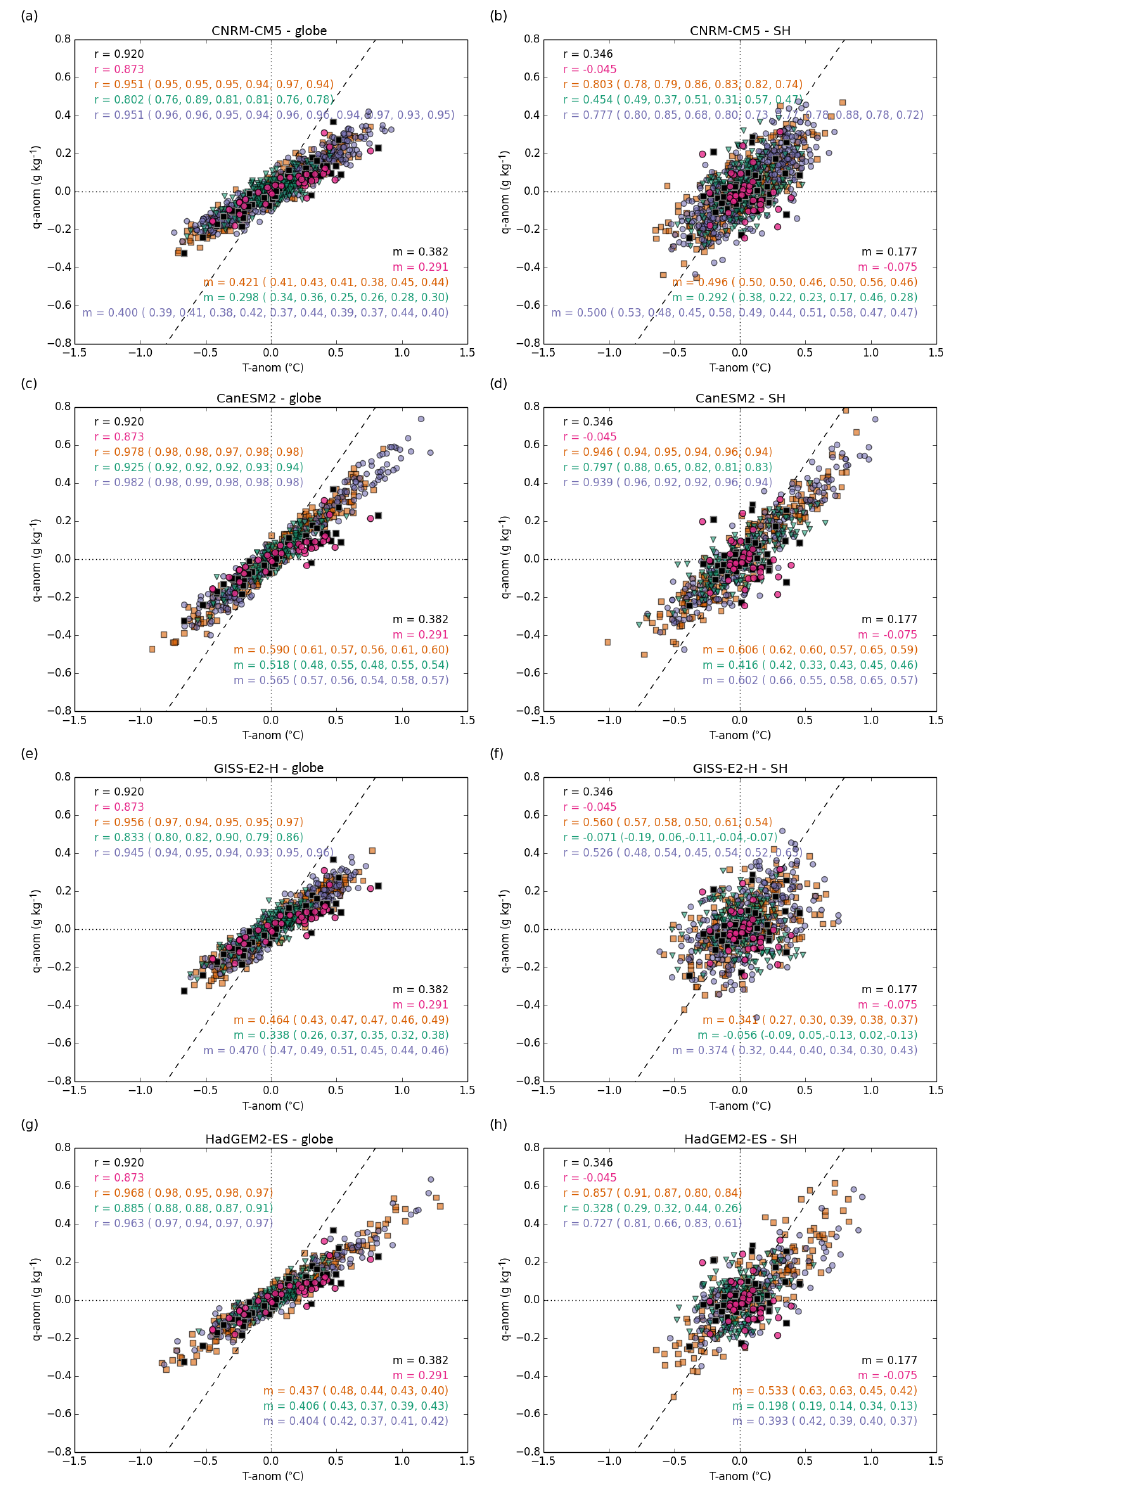
Figure 8. Relationships between temperature and specific humidity for the globe (a, c, e, g) and Southern Hemisphere (b, d, f, h) for a selection of CMIP5 models compared to HadISDH and ERA-Interim. Correlations ( r ) are shown in the top left-hand corner of each panel. The gradient of the line of best fit is given in the bottom right-hand corner of each panel. HadISDH is shown in black. ERA-Interim is shown in magenta. Historical, historicalNat and historicalGHG are shown in purple, green and orange respectively. The ensemble mean value is given for each model with individual member values in